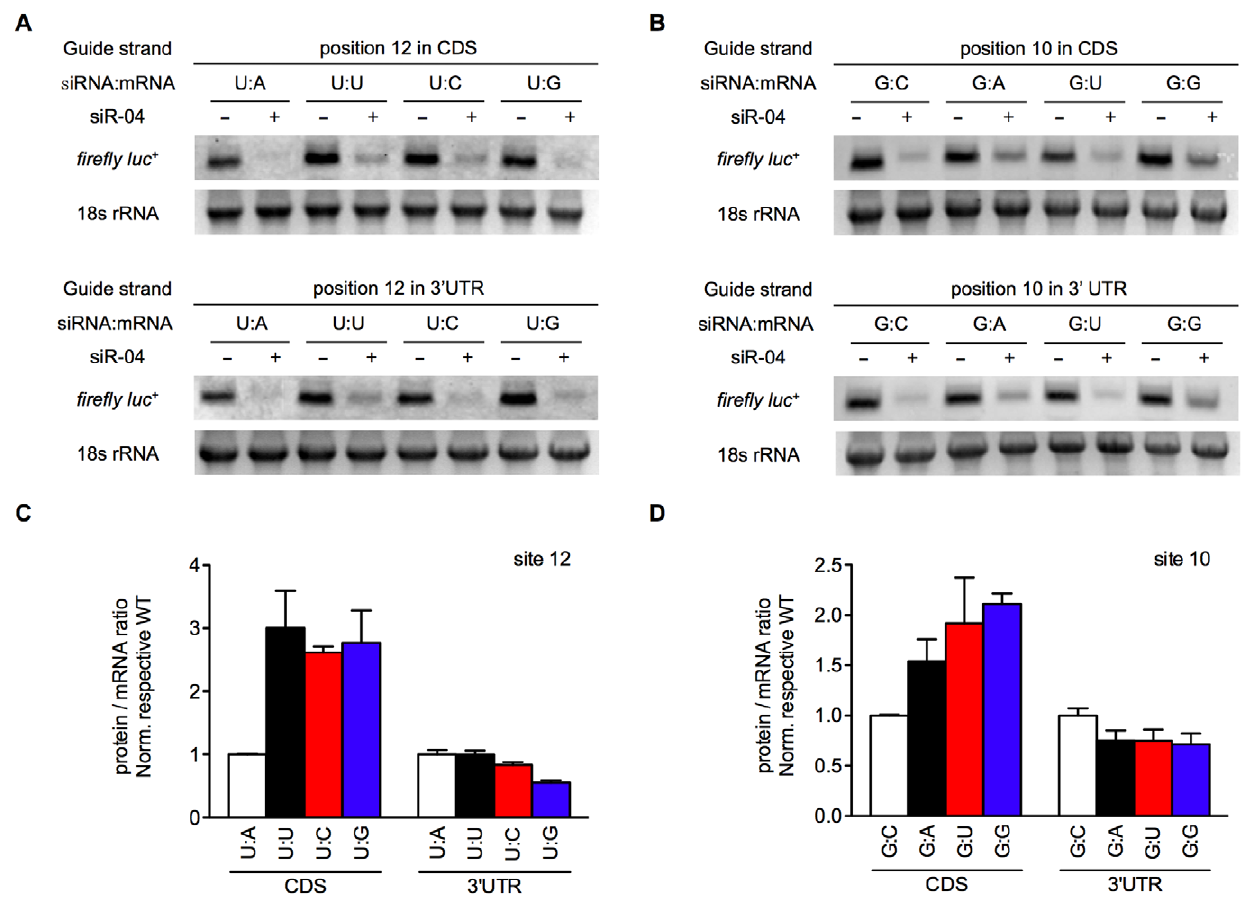
Figure 3. Translational repression contributed to elevated mismatch tolerance in 3 9 -UTR. (A,B) Northern blot was performed with mRNA transcripts harboring perfectly matched or single-nucleotide mismatched targets of siR-04, located in CDS or 3 9 -UTR respectively. Reporter plasmids mutated at position 12 or 10 at each location were co-transfected into HEK293A cells with ( + ) or without (-) the siRNA, and then the amount of reporter mRNA was evaluated using biotin-labeled RNA probe. 18S rRNA was included as loading control. (C,D) Comparison of gene silencing in mRNA and protein levels at position 12 (C) and 10 (D). The intensity of mRNA bands was quantified by ImageJ software, while silencing efficacy of siRNA on protein level was reflected by reporter enzyme activity. The target site location and siRNA:mRNA match pattern were given under the x-axis. The y-axis represented protein yield by the remaining mRNAs, and this repression ratio of siR-04 targeting to mismatched site was normalized to that targeting to perfectly matched site (WT) at either location. Error bars represented SD. All experiments were performed at least twice.